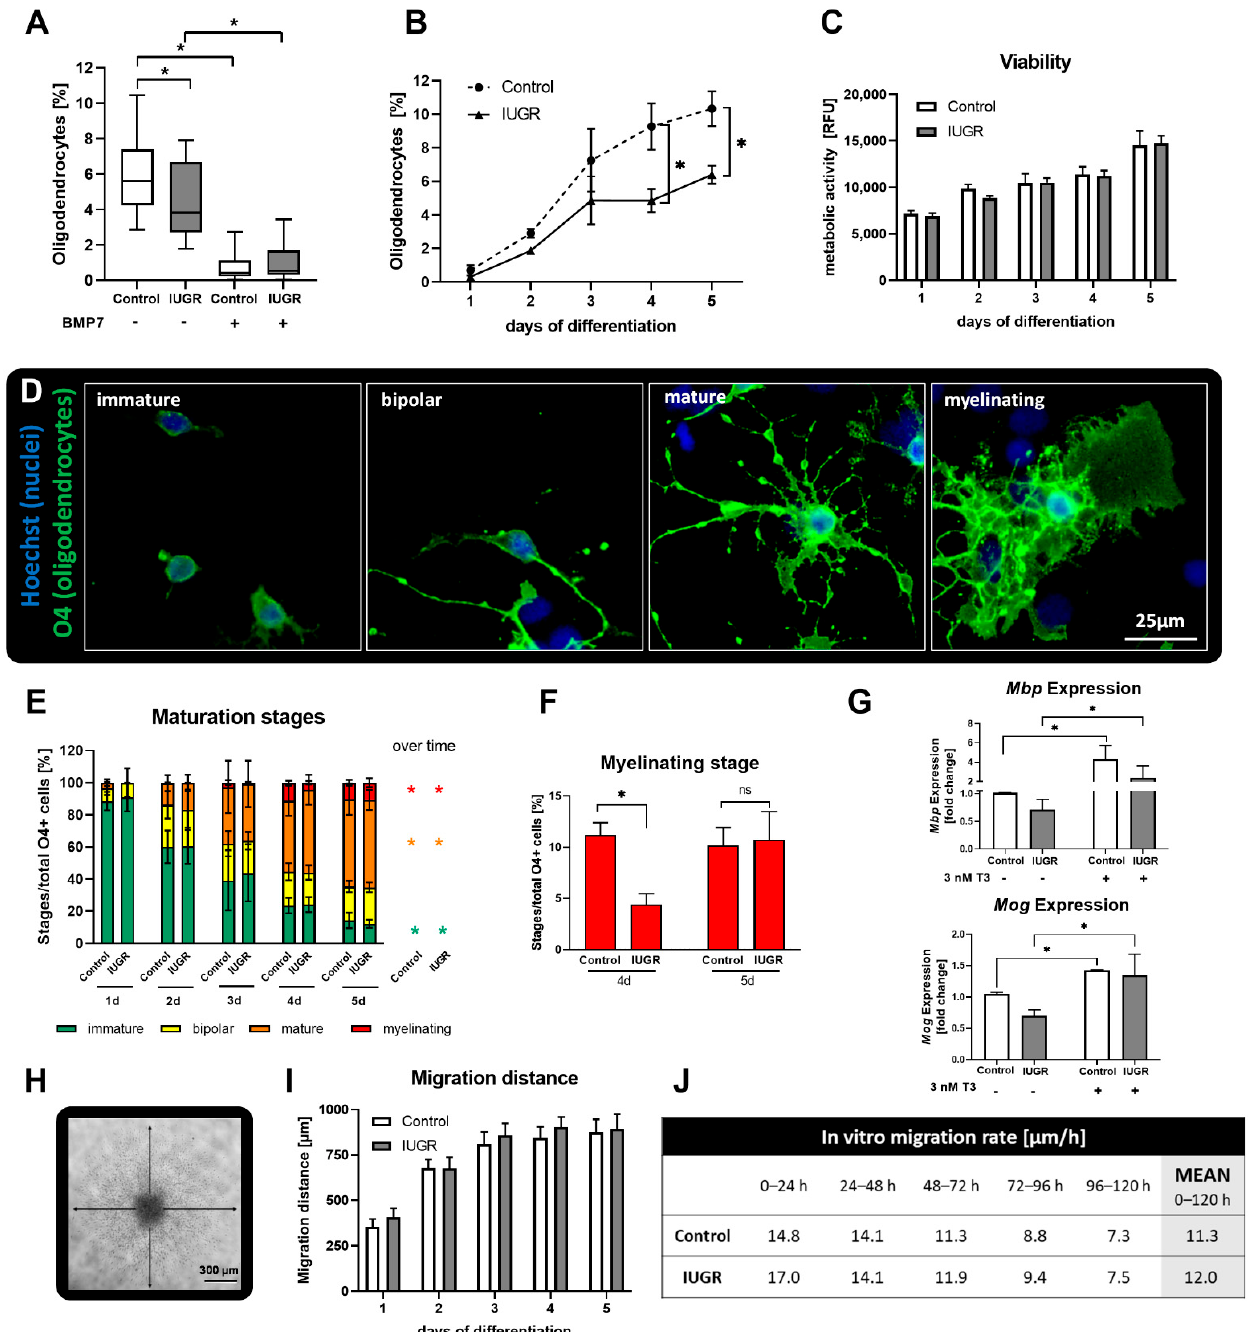
Figure 2. Oligodendrogenesis. Rabbit neurospheres obtained from control and IUGR pups were comparatively analyzed for each endpoint of the ‘Neurosphere Assay’. ( A ) Oligodendrocyte differentiation after 5 days with and without exposure to the positive control BMP7 [100 µ M], ( B ) oligodendrocyte differentiation over five consecutive days, ( C ) cell viability determined by metabolic activity, ( D ) representative pictures of maturation stages in control neurospheres, from left to right: immature, bipolar, mature, myelinating with oligodendrocyte marker O4 (green) and nuclei marker Hoechst 33,258 (blue), scale bar = 25 µ m. ( E ) Maturation stages of oligodendrocytes (O4+ cells) evaluated by morphological appearance over five days, ( F ) myelinating stage after 4 and 5 days, ( G ) qRT-PCR from Mbp and Mog expression in control and IUGR neurospheres, with and without exposure to the positive control 3 nM T3. ( H ) Representative picture of migrated NPCs after 3 days, ( I ) migration distance [ µ m] and ( J ) Migration rate [ µ m/h]. Mean ± SEM; ns: not significant, *: p <